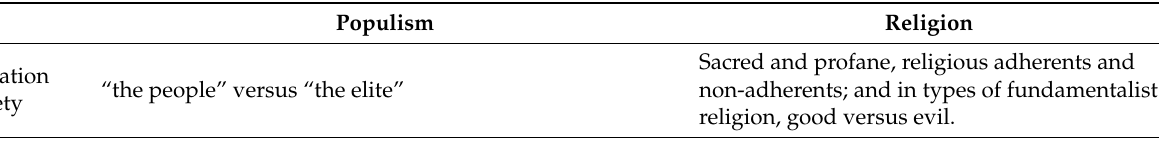
Table 1. Populism borrowing from